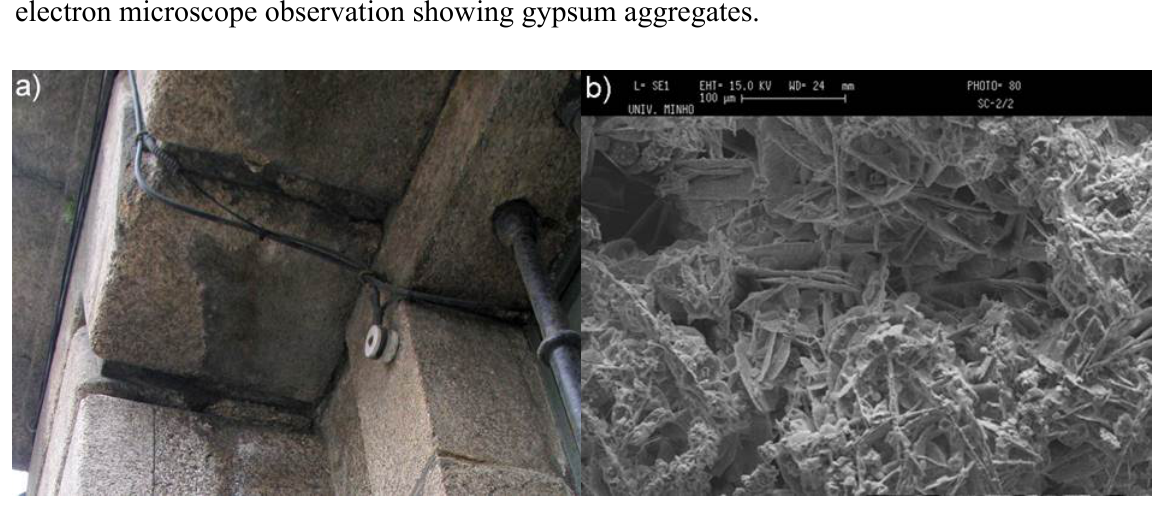
Figure 4. Images of black crusts on granite buildings: (a) field observation; (b) scanning electron microscope observation showing gypsum aggregates.